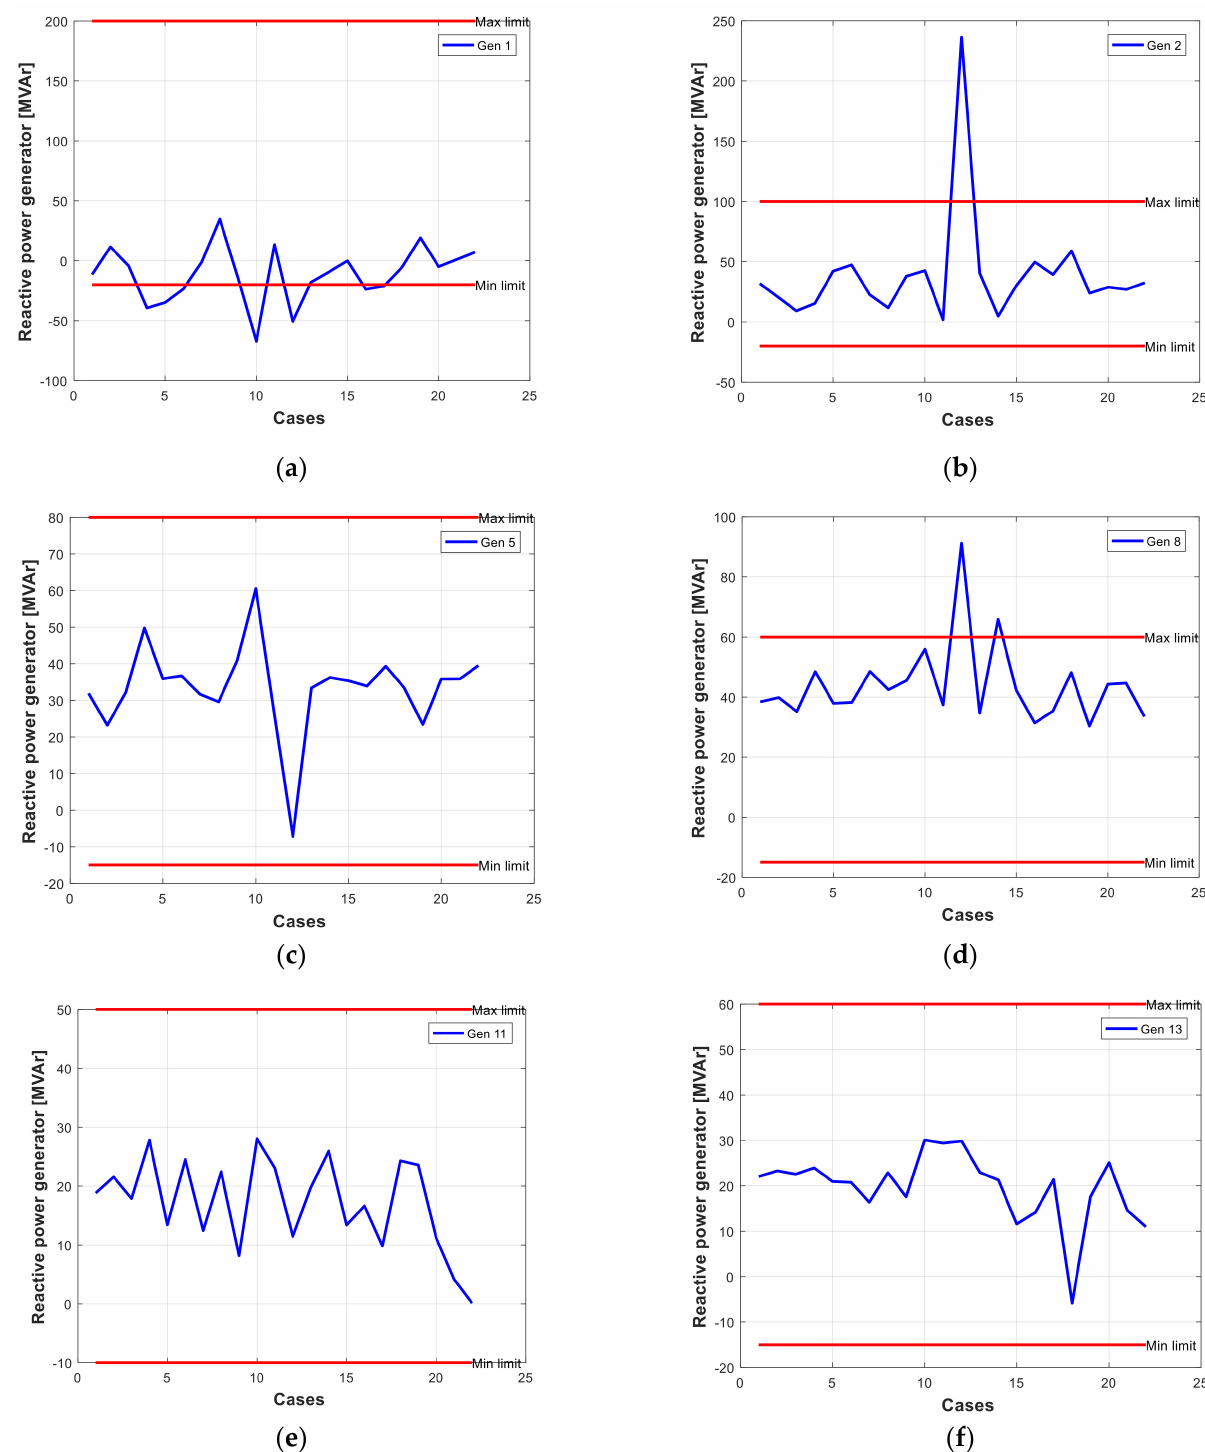
Figure 9. The reactive power output of generators for Cases 1-22 on the IEEE 30-bus